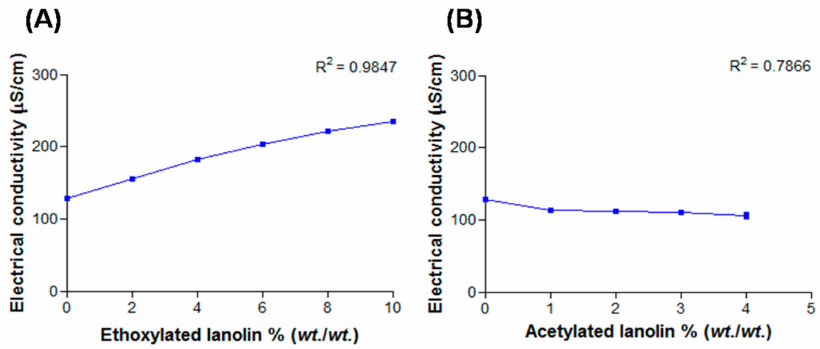
Figure 3. Electrical conductivity values in function of lanolin derivatives: ( A ) EL and ( B )